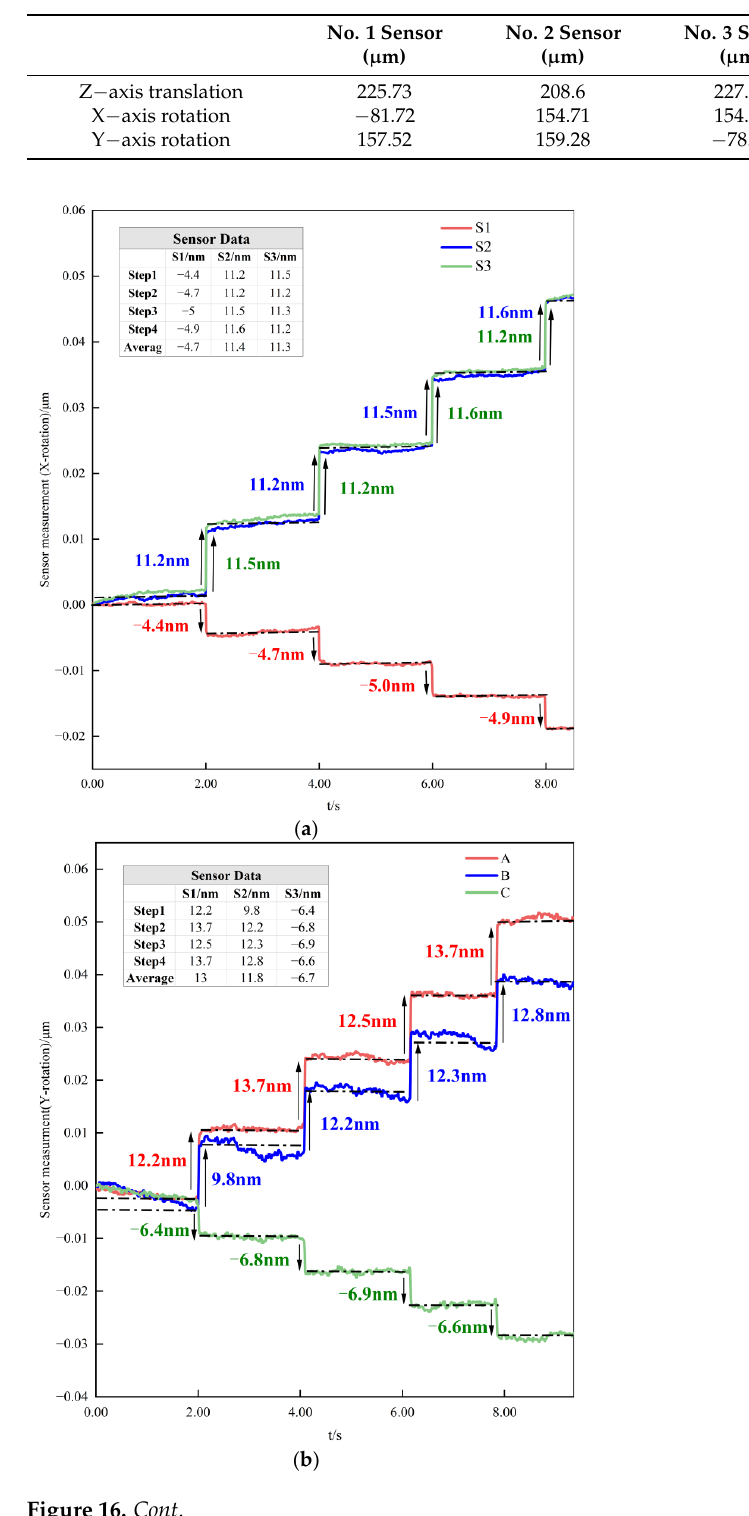
Table 5. 3 − DOF stroke of piezoelectric platform.